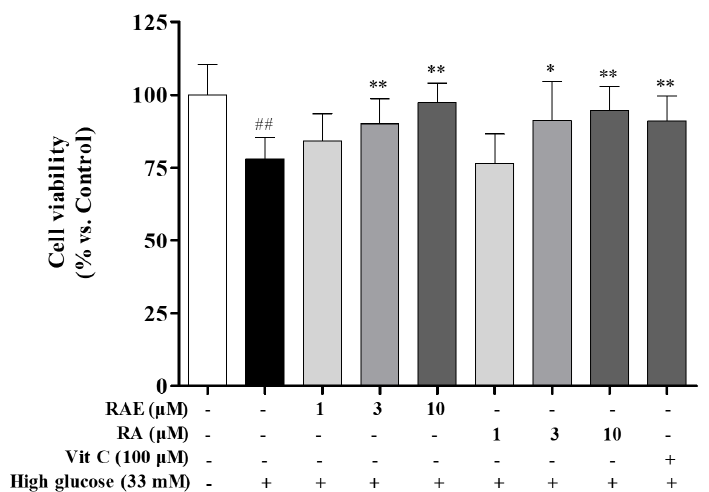
Figure 1. Effect of ethyl rosmarinate (RAE) and rosmarinic acid (RA) on cell viability in high glucose-induced human endothelial cells. EA.hy926 cells were treated with RAE (1, 3, and 10 µM), RA (1, 3, and 10 µM) or positive control Vit-C (100 µM), respectively, in the medium containing 33 mM of glucose for 72 h. The results were expressed as mean ± SD (n = 3). ## P < 0.01, vs. control; * P < 0.05, ** P < 0.01, vs. high glucose.